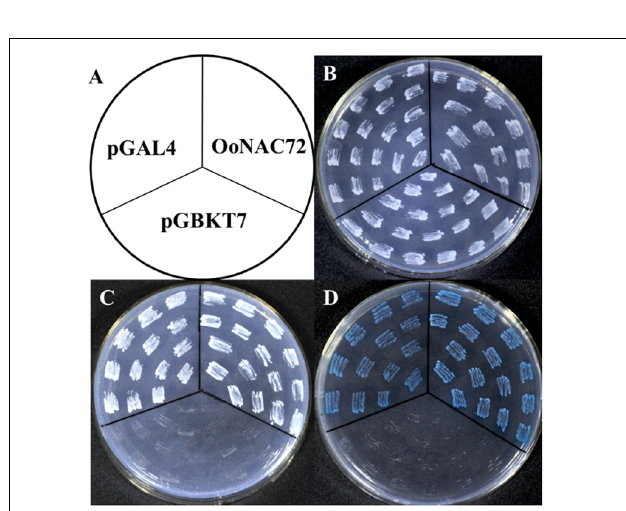
FIGURE 2 | Transcriptional activation assay of the OoNAC72 in yeast cell. (A) Schematic Diagram. The numbers on the left indicate the last residues of polypeptides. Vectors pGBKT7 and pGAL4 were used as negative and positive control, respectively. All plasmids were transformed into the yeast strain AH109 (B–D) . Transformed yeasts were dripped on the SD/-Trp, SD/-Trp-His-Ade, and SD/-Trp-His-x-gal after being cultured for 3 days in the growth